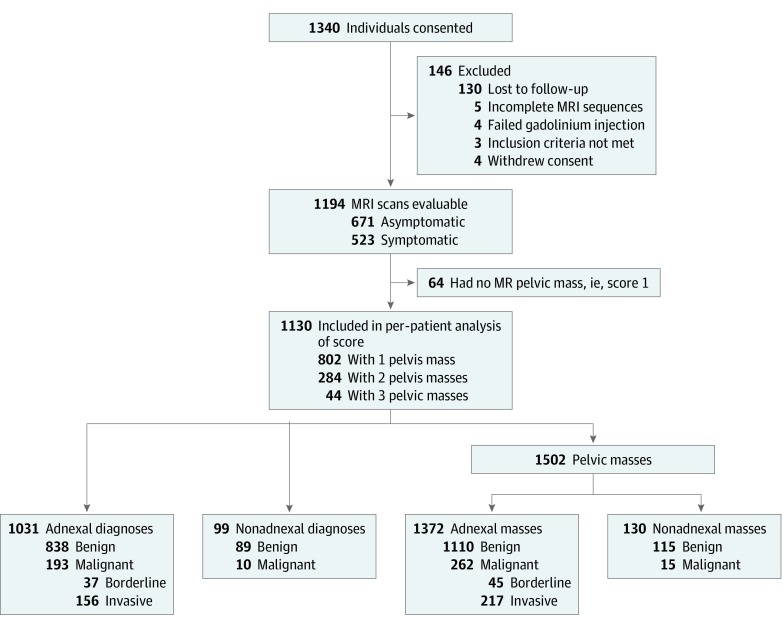
Study Population Flow DiagramMR indicates magnetic resonance; MRI, magnetic resonance imaging.